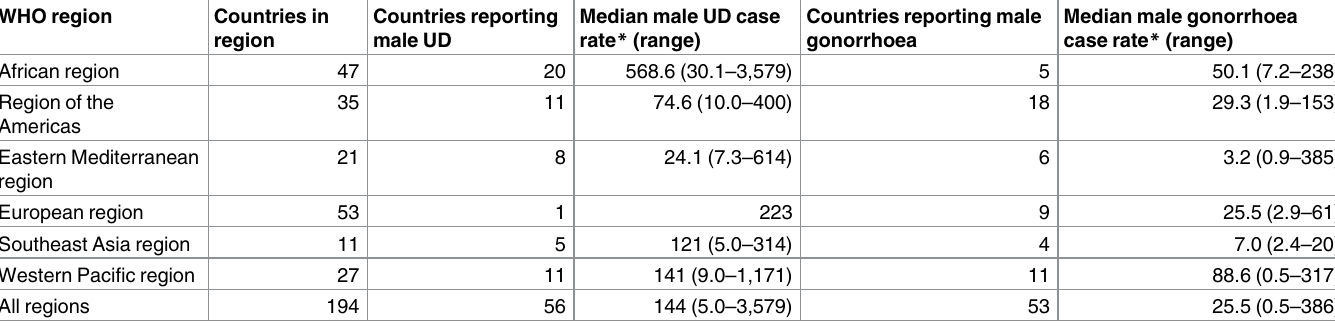
Table 1. Male urethral discharge (UD) rate and male gonorrhoea case reporting rates by region, 2014. WHO region Countries in